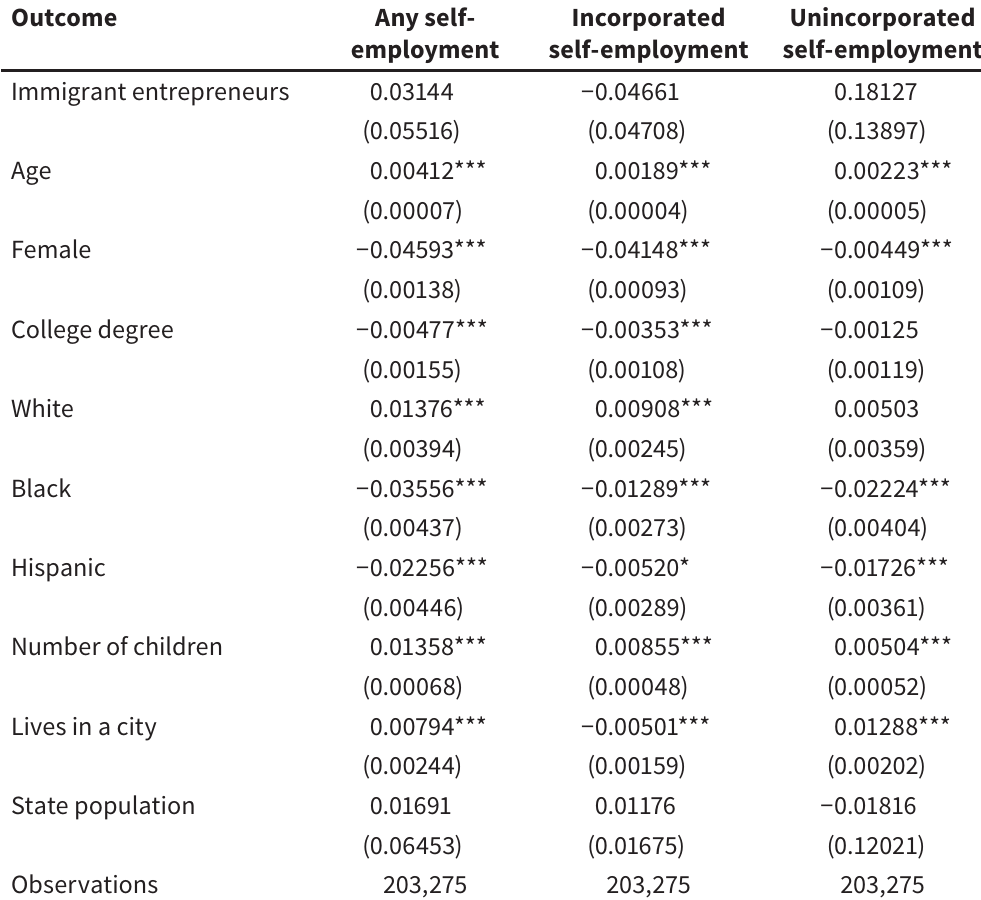
Heterogeneity in the Impact of Immigrant Entrepreneurs across Skill Levels of Natives: Second Stage Estimates for High